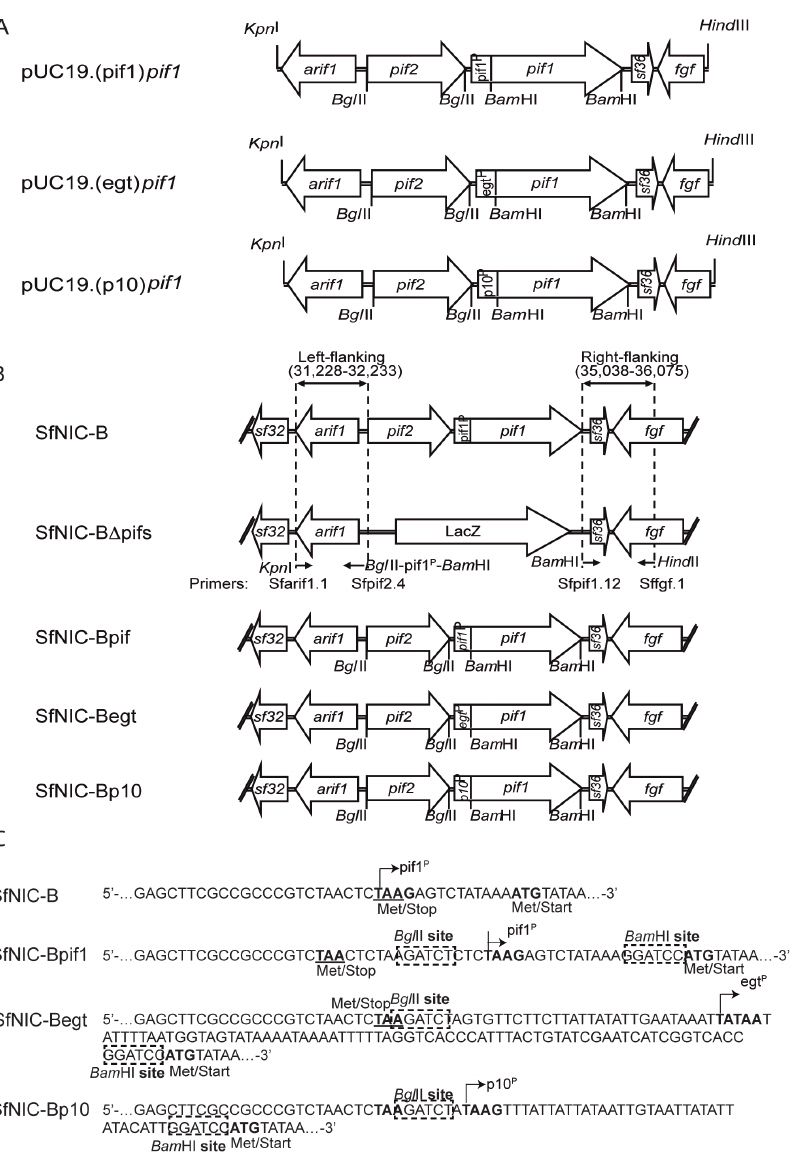
Figure 1. Promoter-exchange donor constructs and intergenic viral sequences. A) Donor plasmids used in this study. B) Viruses used in this study. The sequence of the complete genotype SfNIC-B is shown, where the right and left pif-2 / pif-1 flanking regions are specified. First, a SfNIC- B D pifs recombinant virus was constructed in which pif-2/pif-1 coding region was substituted by the LacZ operon. The primers used for the flanking regions amplifications are indicated below the figure. Recombinant viruses SfNIC-Bpif1 (rescue virus), SfNIC-Begt, in which the SeMNPV egt promoter would drive pif-1 transcription, and SfNIC-Bp10, in which the SeMNPV p10 promoter would drive pif-1 transcription, were constructed by homologous recombination between SfNIC-B D pifs and donor plasmids pUC19.(pif1)pif1, pUC19.(egt)pif1 and pUC19.(p10)pif1 respectively. C) pif-2 / pif-1 intergenic sequences from SfNIC-B, SfNIC-Bpif1, SfNIC-Begt and SfNIC-Bp10 viruses. The underlined portion in SfNIC-B containing the native pif-1 promoter was replaced by donor